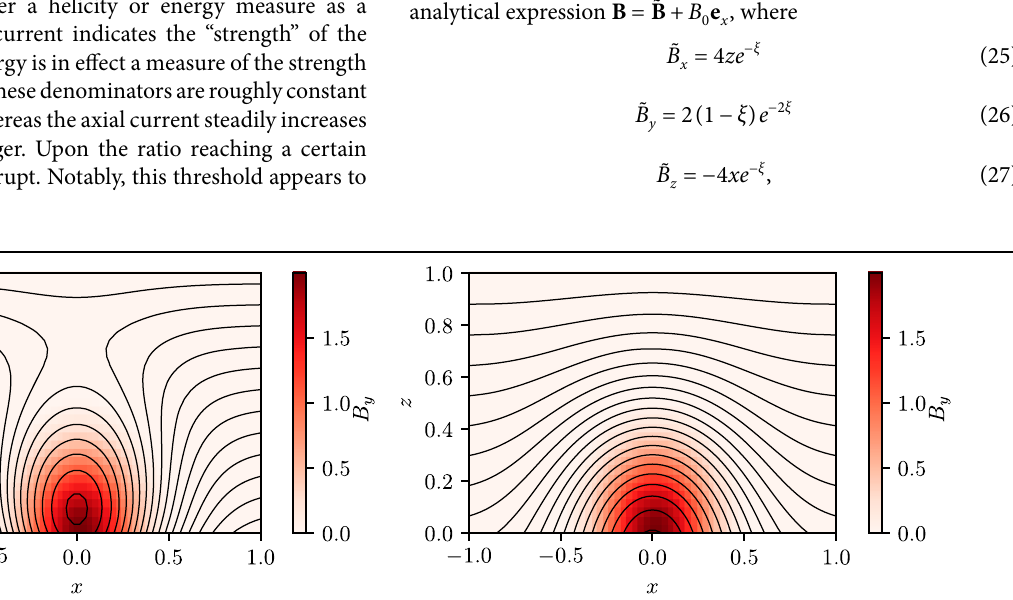
Frontiers in Astronomy and Space Sciences |